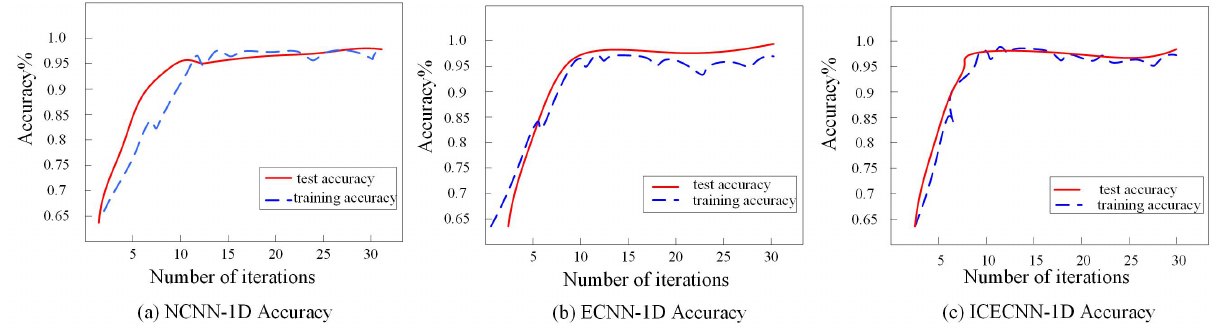
Figure 4. The accuracy trend of three models’ function.